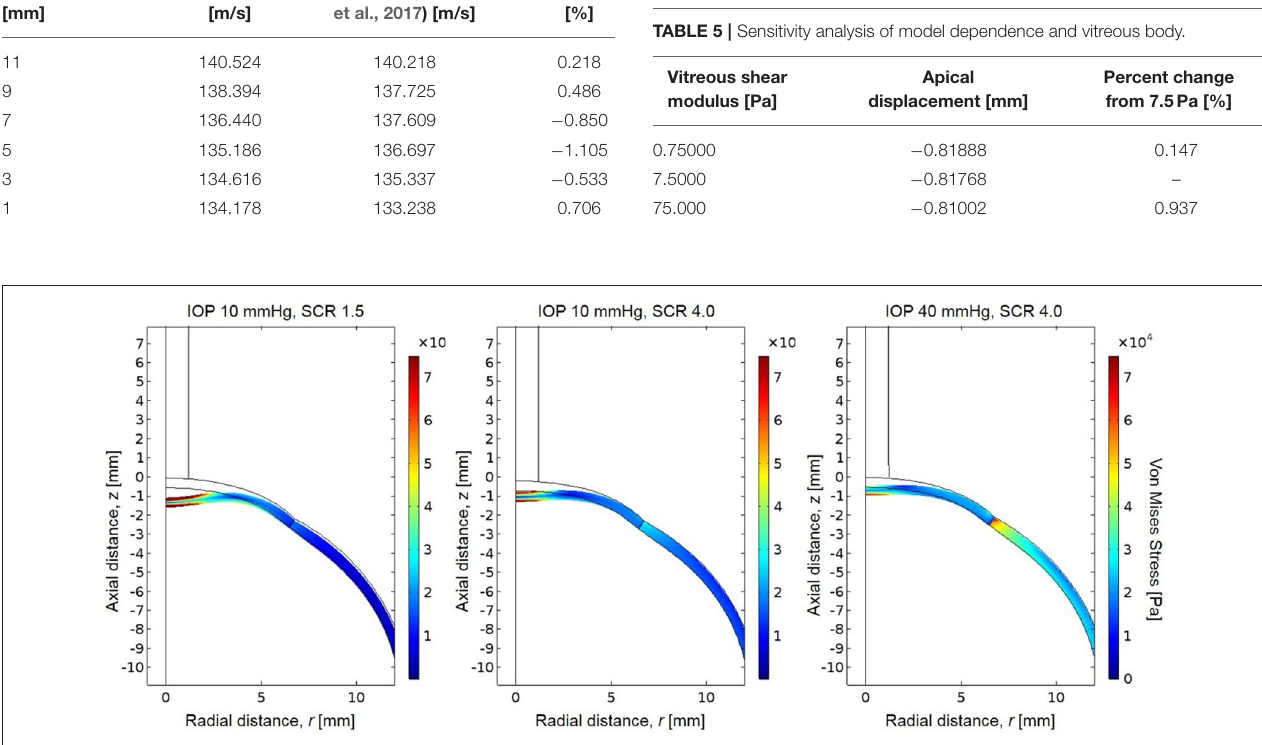
FIGURE 6 | Resultant von Mises stresses and deformation for a globe with scleral-to-corneal ratio of Young’s moduli of 1.5 and IOP of 10 mmHg (left) , scleral-to-corneal ratio of 1.5 and IOP of 40 mmHg (center) , and a globe with scleral-to-corneal ratio of 4.0 and IOP of 40 mmHg (right) .